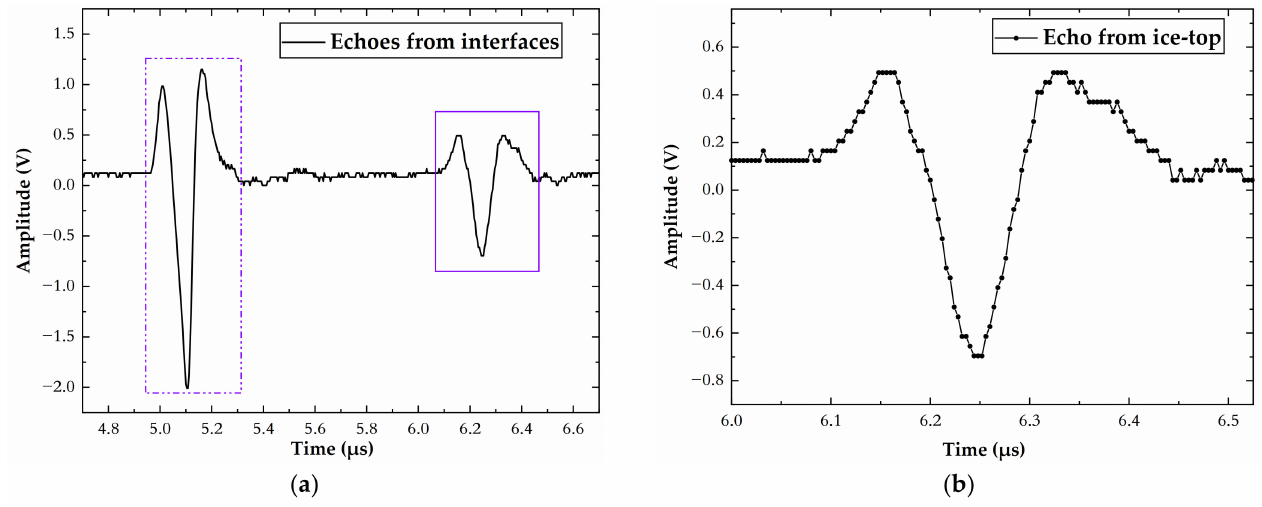
Figure 9. Data obtained from test with surface roughness of Sa = 40 µ m. The pulse in the dot-dashed rectangle is the first echo from the substrate–ice interface, and the pulse in the solid rectangle is the first echo from the top of the ice. ( a ) Experimental echo waveform. ( b ) Waveform from top of